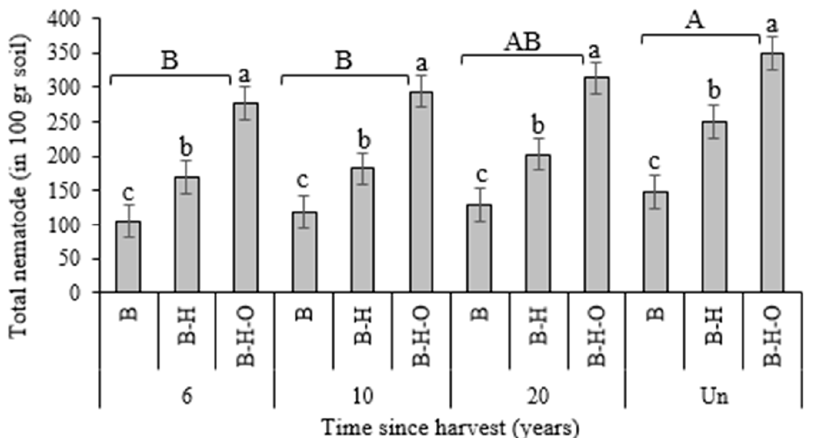
Figure 4. Mean values of total nematodes in different years since harvest under three litter treatments. The studied litter treatments were beech (B), beech–hornbeam (B-H), and mixed beech (B-H-O). Harvesting period: 6, 10, and 20 years after harvest. For total nematodes, time since harvest (F = 473.015; p < 0.001), traffic intensity (F = 220.172; p < 0.001), and their interaction (F = 29.145; p = 0.021). Different capital and lowercase letters indicate significant differences ( p < 0.05 by Duncan test) between harvesting period (year after harvest) and litter treatments, respectively. Table 2. Mean values (±SE) of total nematodes (in 100 g soil) in different years after harvest under different traffic intensities; HT: skid trail with high traffic intensity, MT: skid trail with medium traffic intensity, LT: skid trail with low traffic intensity, and UN: undisturbed area. Traffic Intensity Time Since Har- vest